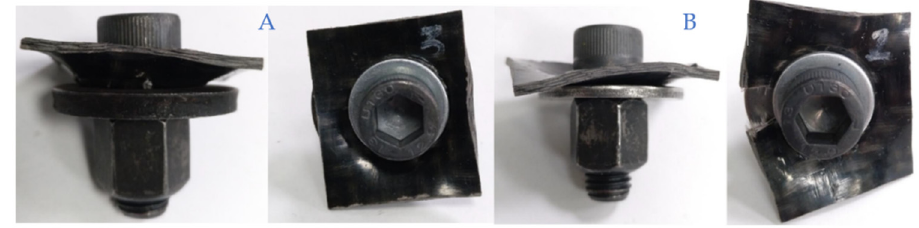
Figure 5. Specimen PA6 FG45 with washer: ( A ) Absence of crack failure after applying the maximum torque. ( B ) Crack failure (Torque > maximum tightening torque).